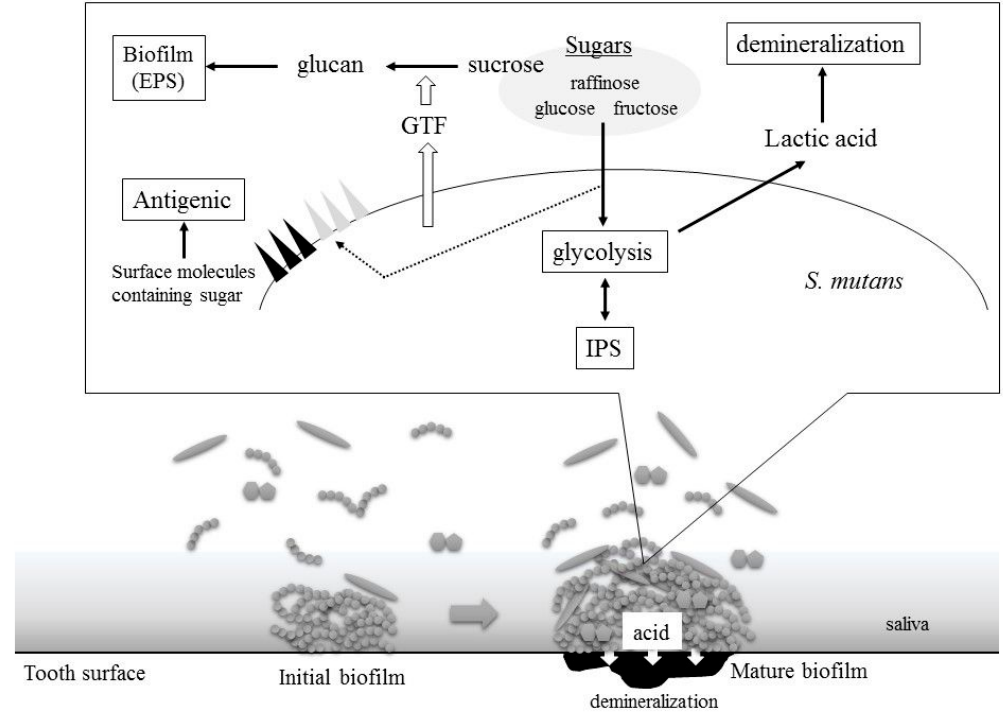
Figure 1. Streptococcus mutans virulence is related to sugars. GTF: glucosyltransferase; IPS: intercellular polysaccharide; EPS: extracellular polysaccharide.